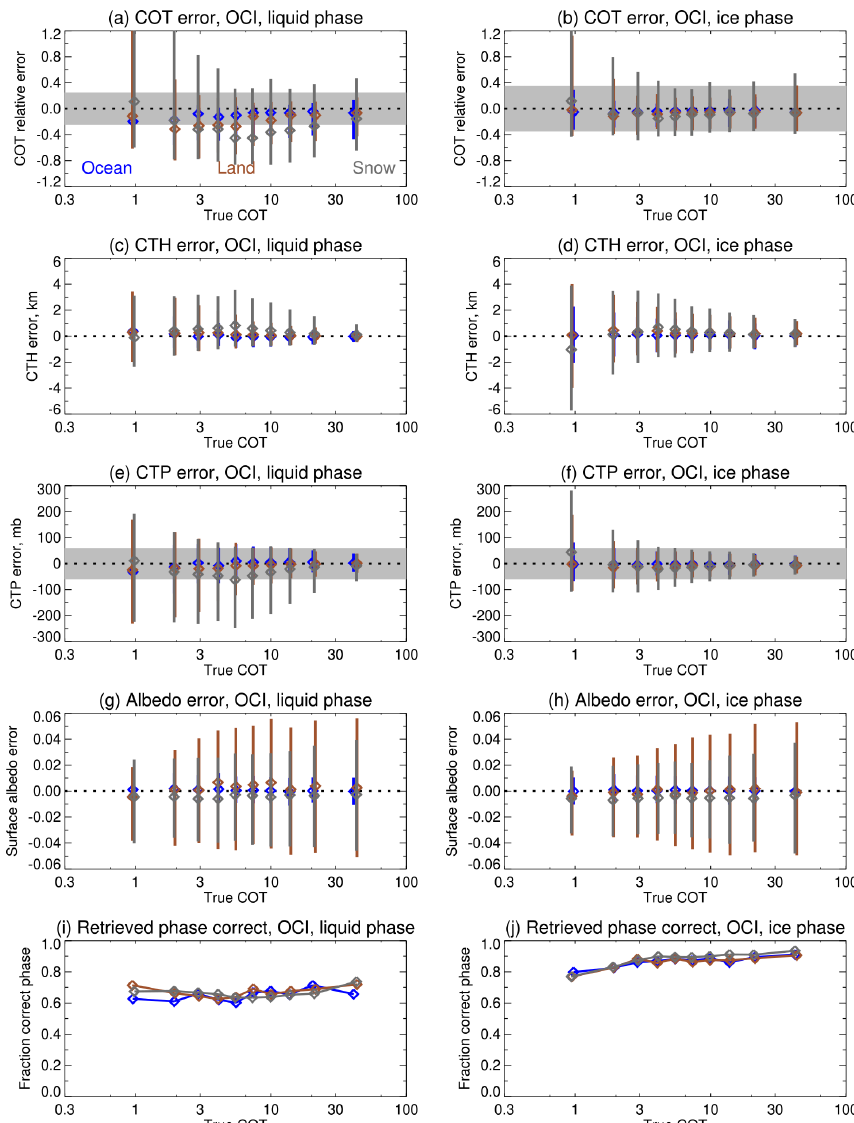
Figure 11. Retrieval errors binned as a function of COT for the simulated single-layer cloud systems for OCI. Points indicate the median retrieval error and vertical lines the central 1 σ of results within each bin. Blue, brown, and grey indicate ocean-like, land-like, and snow- like simulations. Panels (a) , (c) , (e) , (g) , and (i) show results for liquid-phase simulations and panels (b) , (d) , (f) , (h) , and (j) for ice-phase simulations. From top downwards, rows indicate COT, CTH, CTP, and surface albedo. Panels (i) and (j) show the fraction of data where the best-fit phase (liquid or ice) is the correct phase for the simulation. Grey shading indicates the PACE mission goal uncertainties: 25% for liquid-phase COT, 35% for ice-phase COT, and 60mb for CTP (the latter for COT ≥ 3 only). The dotted line indicates an error of